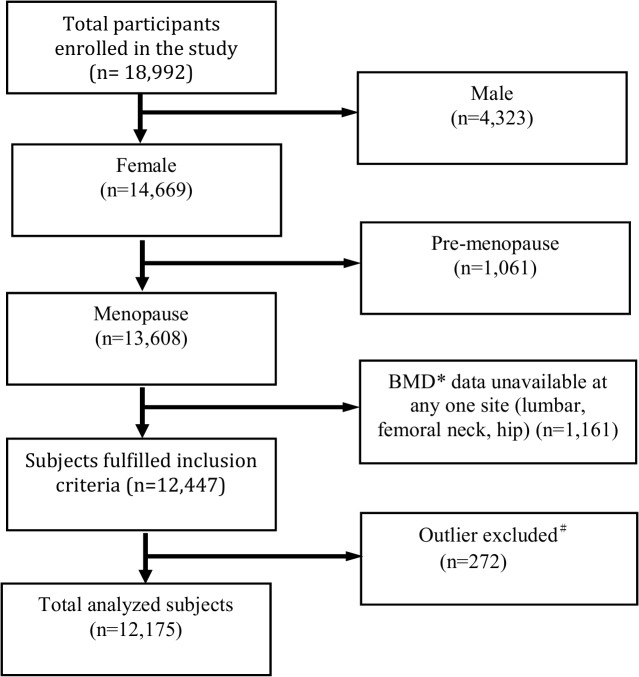
Disposition of participants.Participants whose BMD was missing at any one site for any reason and participants with extreme values (deviating from the mean by more than three times the standard deviation) were excluded from data analysis.